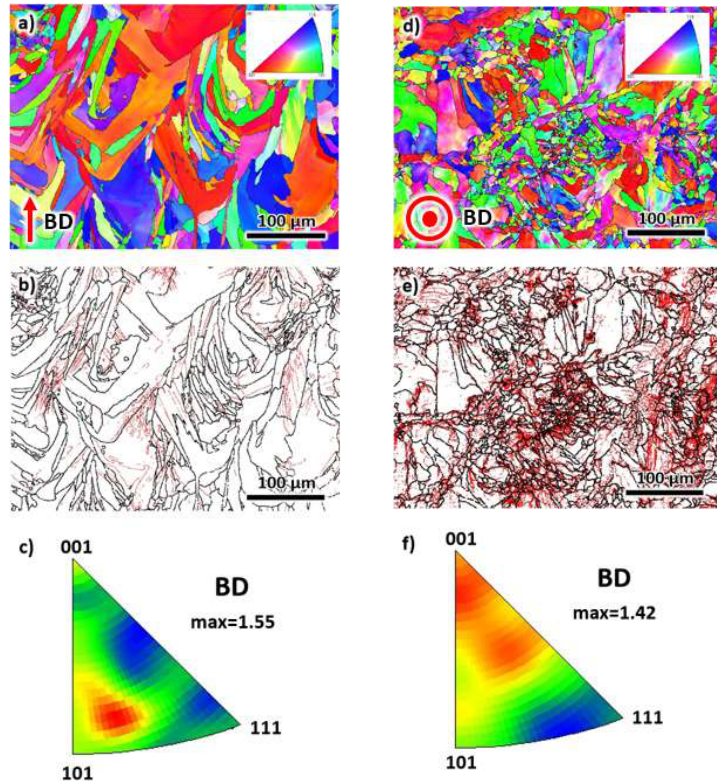
Figure 4. The ( a ) electron backscatter di ff raction (EBSD) inverse pole figure (IPF)-Z map, ( b ) the grain boundary distribution map, and ( c ) the IPF representation of grains of as-printed 316L samples taken from the building direction. Similarly, the ( d ) EBSD IPF-Z map, ( e ) the grain boundary distribution map, and ( f ) the IPF representation of grains of as-printed 316L samples taken from the transverse direction.